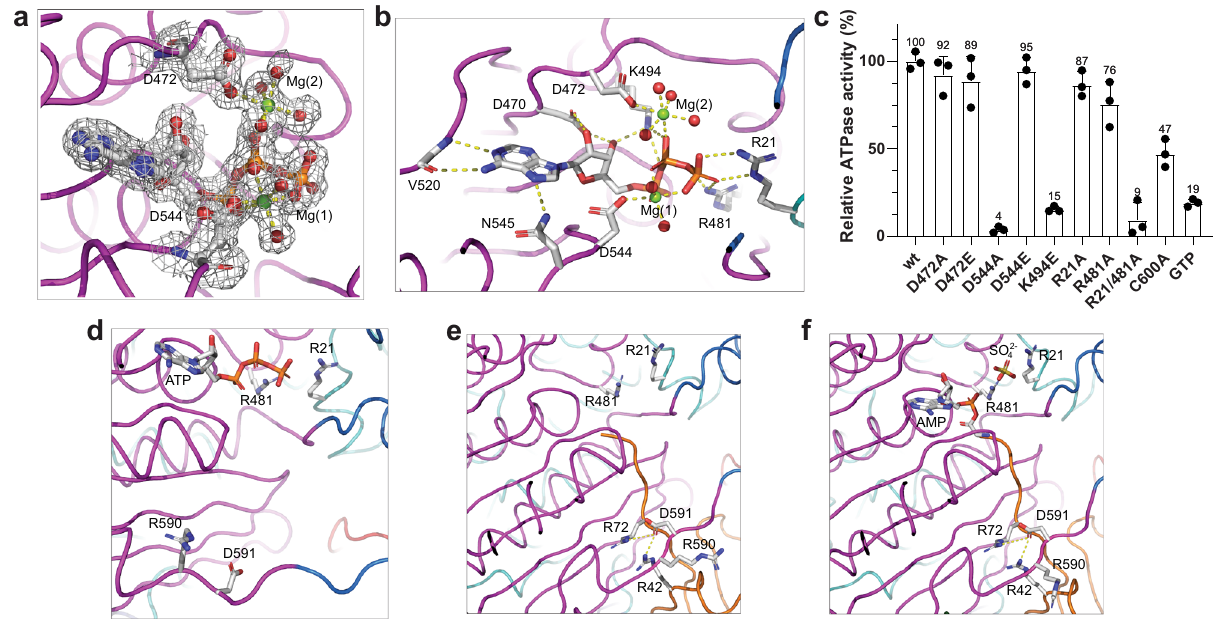
Fig. 2 | Comparison of the Mg 2+ -ATP-UBA6 and Mg 2+ -ATP-Uba1 complexes. a SIGMAA-weighted 2F o -F c electron density for ATP, the two Mg 2+ -ions (Mg(1) and Mg(2)) and the coordinating Asp residues in the high resolution Uba1-ATP com- plex. b Coordination of the nucleotide cofactor in the high resolution Uba1-ATP structure with direct interactions highlighted as dashed yellow lines. c ATPase activity assays of Uba1 wild-type and variants, n =3 independent replicates, data